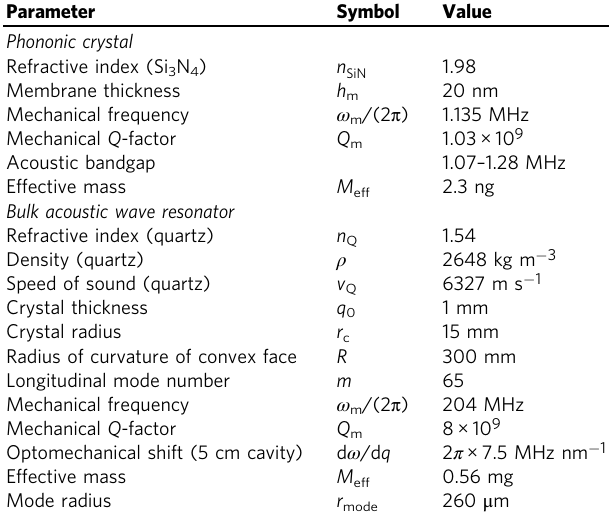
mirror couples the interferometer dark port, negative dispersion fi lter, and output photodiode. Frequency dependent squeezing may be applied by injecting squeezed vacuum at the output Faraday isolator 31 . The negative dispersion fi lter is cooled to temperatures of 1 – 4 K and contained inside a radiation shield to minimise radiation heating and scattered light noise. A model of the PNC resonator is shown in Fig. 1, embedded in a 2- dimensional phononic lattice. High Q m has been demonstrated for silicon nitride PNC resonators of size 87 – 346 μ m 32 . Other resonator properties relevant to WLSR are shown in Table 1.